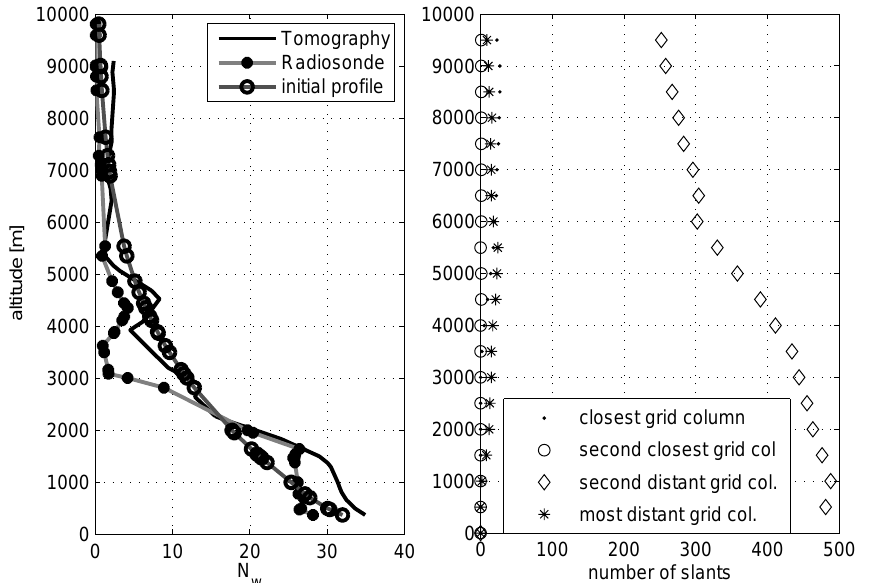
Fig. 4. Vertical profiles at station K¨ummersbruck on 28 March 2007, 12:00UTC (left panel) and the number of slant paths per voxel in four adjoining columns for interpolation (right panel).